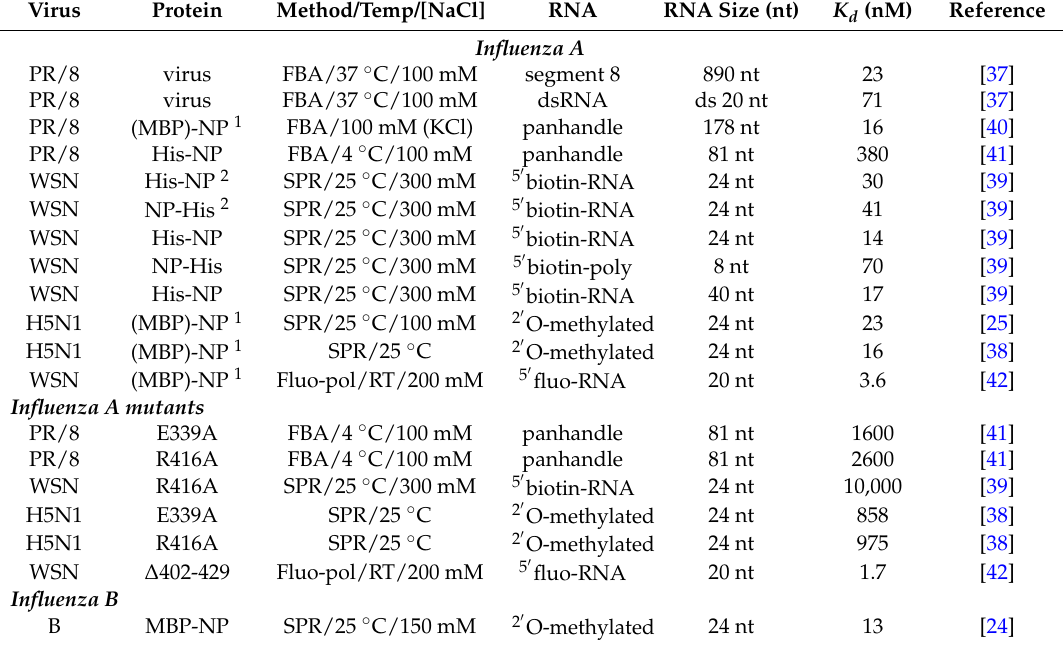
Table 1. Affinities of the nucleoproteins of influenza A and B for different RNAs. This table summarizes the results of affinity measurements from different studies. These studies used protein from different strains (A/WSN/1933; A/PR/8/34; A/HK/483/97(H5N1); B/Panama/45/90). Proteins are recombinant protein or directly purified from the virus. Recombinant proteins are MBP- or His-tagged. The MBP tag is cleaved after the first purification step. Different techniques were used to measure the affinities between nucleoprotein (NP) and RNA: filter binding assay (FBA), surface plasmon resonance (SPR), and polarization of fluorescence (Fluo-pol). Experiments were done at different temperatures, with different NaCl concentrations (from 100 to 300 mM) and with different RNAs (from eight to 890